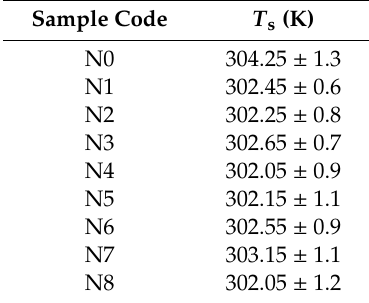
Table 7. Measurement of surface temperature of the Cu/Ni-coated Milife fabric under 313.15 K by Using Custom-built Setup.